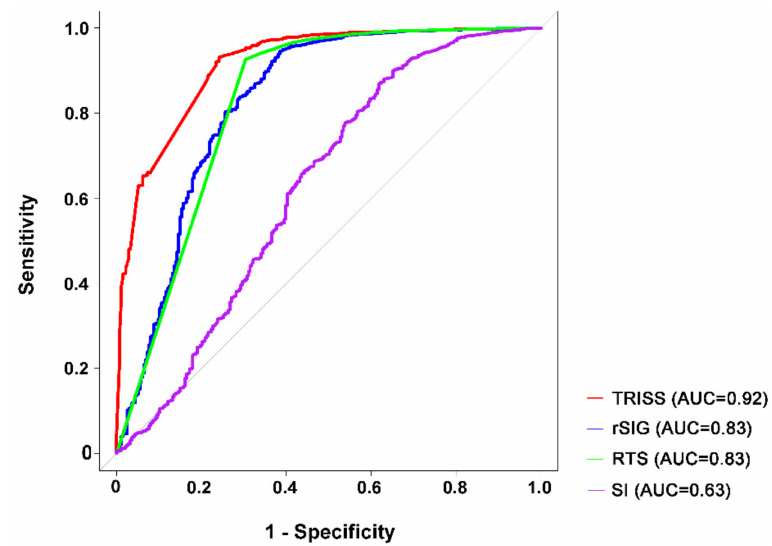
Figure 3. Area under the curve (AUC) of TRISS, rSIG, RTS, and SI in predicting the mortality of patients without head